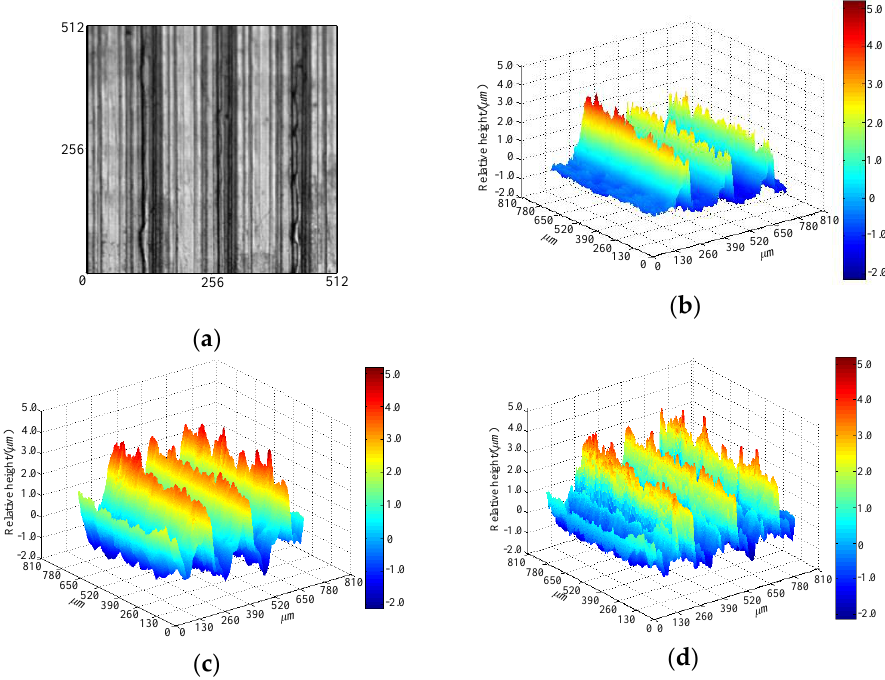
Figure 13. Experimental results for boring surface image: ( a ) Boring surface image; ( b ) Measured result; ( c ) Reconstruction result of Horn and Brooks algorithm; and ( d ) Reconstruction result of proposed algorithm.